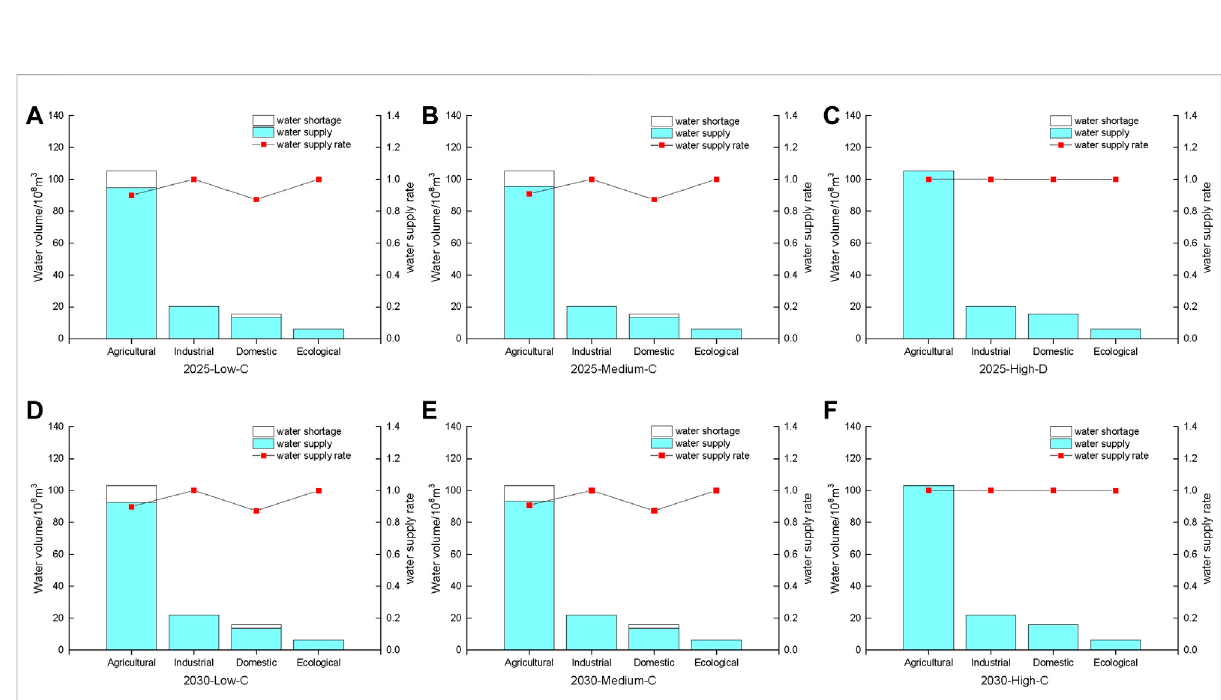
FIGURE 5 Water resource allocation of six suitable scenarios [ (A – F) represent 6 selected scenarios